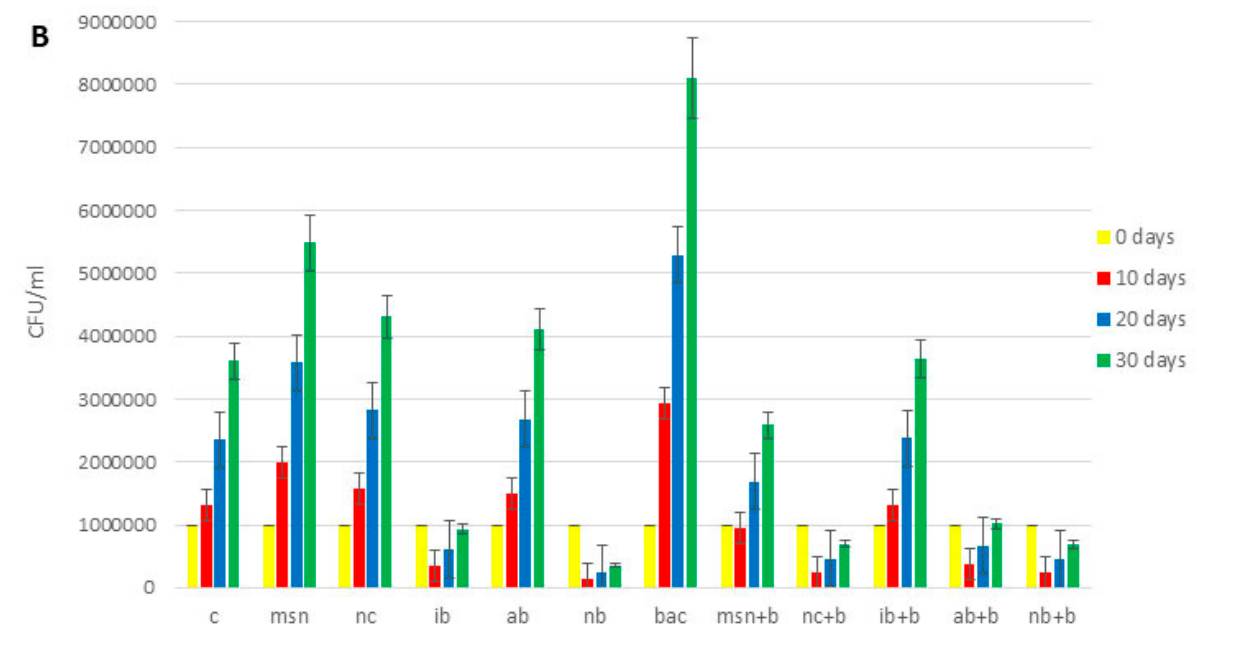
Figure 6. Content of phosphorus-solubilizing bacteria in the soil. ( A ) 2nd tomato experiment; ( B